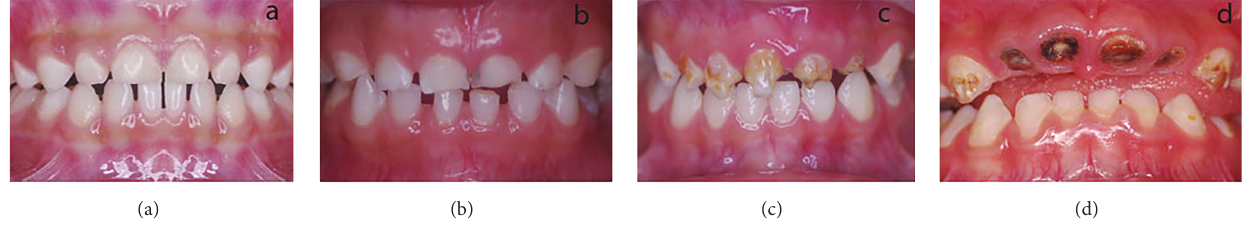
Figure 1: Point at which the respondent would visit the dentist. (a) No caries, (b) initial cavitation of the tooth, (c) deep caries with partial destruction of the crown, and (d) complete destruction of the anterior teeth.